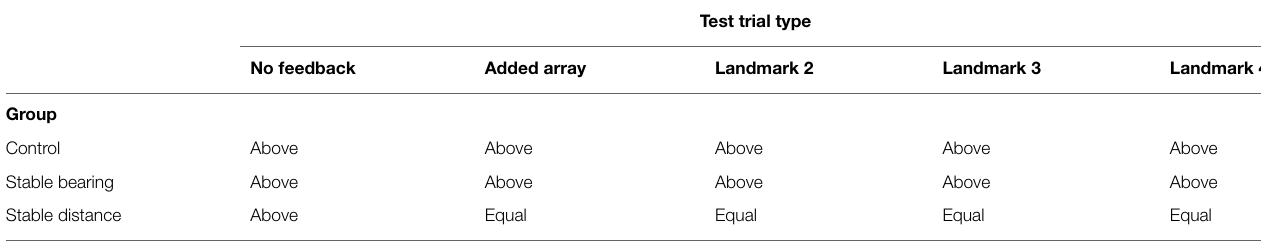
TABLE 1 | Comparisons of preference ratio (time in area designated as correct/total time in area designated as correct and incorrect) relative to chance (0.5) for each group by test trial